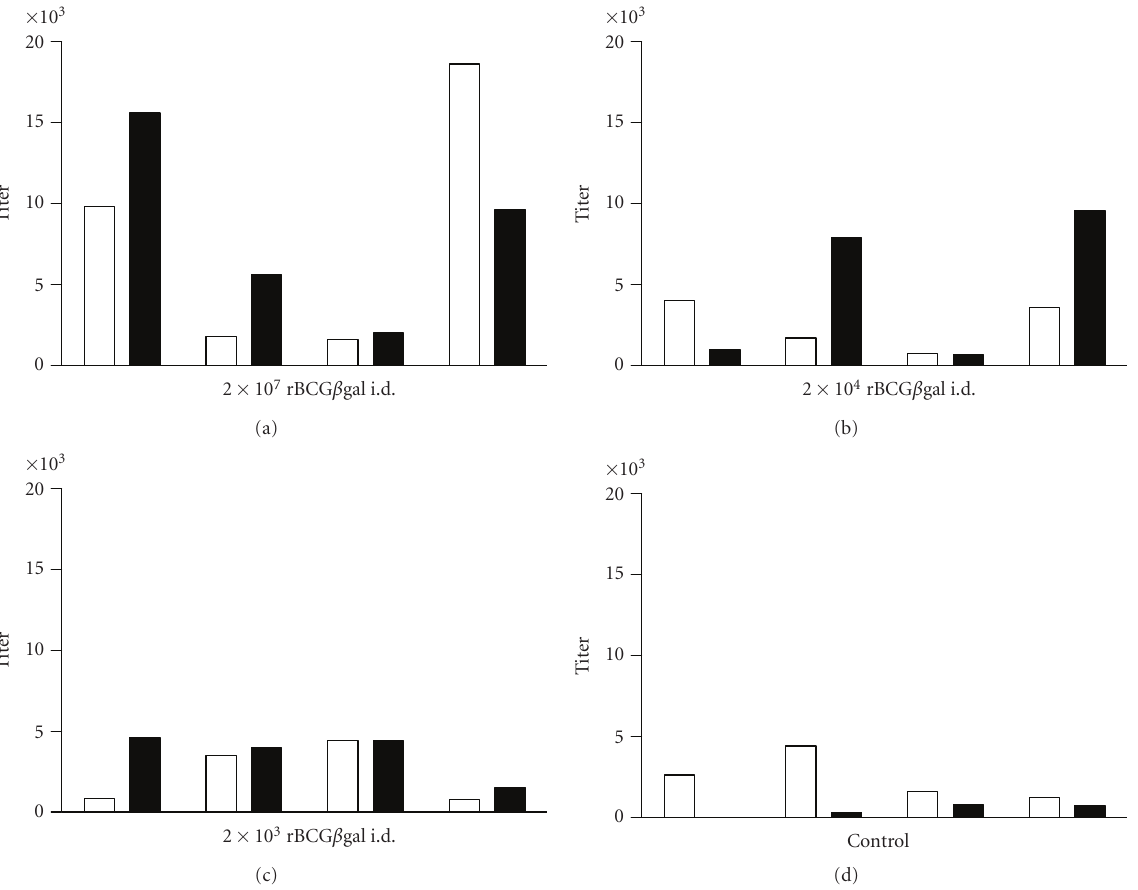
Figure 5: Serum antibody responses of mice to β -gal after immunization with di ff erent doses of rBCG by the i.d. route, and subsequent challenge with a high dose of rBCG by the same route. Mice were immunized initially with doses indicated below each graph with age- matched control mice receiving only challenge dose shown. After 16 weeks, all groups were challenged with 2 × 10 7 rBCG given i.d. Serum was collected at the time the mice were killed, 16 weeks after the challenge. Open bars show IgG1 titers while black bars depict IgG2a